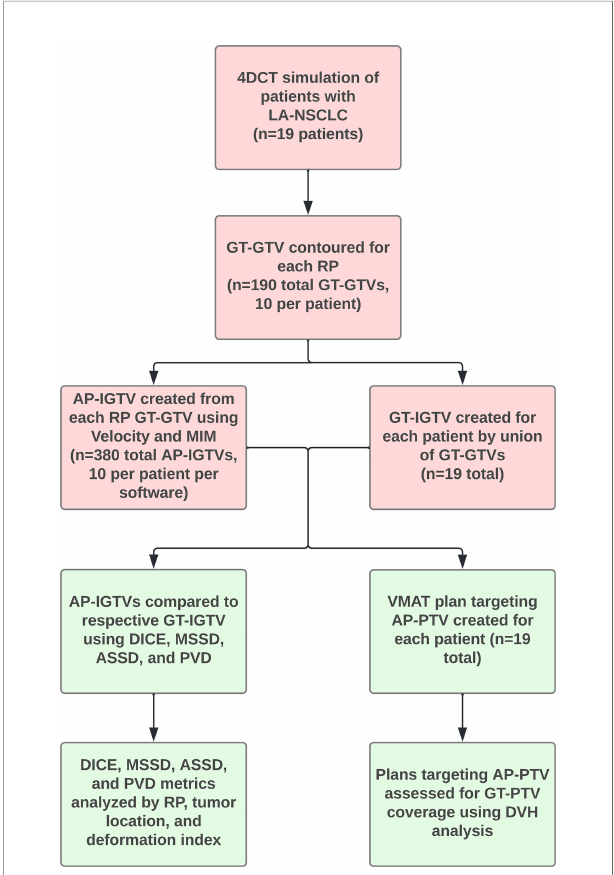
FIGURE 1 | Flowchart with overview of study procedures. Abbreviations: 4D computed tomography (4DCT), auto-propagated internal gross tumor volume (AP-IGTV), auto-propagated planning target volume (AP-PTV), average symmetric surface distance (ASSD), Dice coef fi cient (DICE), dose volume histogram (DVH), ground-truth gross tumor volume (GT-GTV), ground-truth internal gross tumor volume (GT-IGTV), ground-truth planning target volume (GT-PTV), locally advanced non-small cell lung cancer (LA-NSCLC), maximum symmetric surface distance (MSSD), percent volume difference (PVD), respiratory phase (RP), and volumetric modulated arc therapy